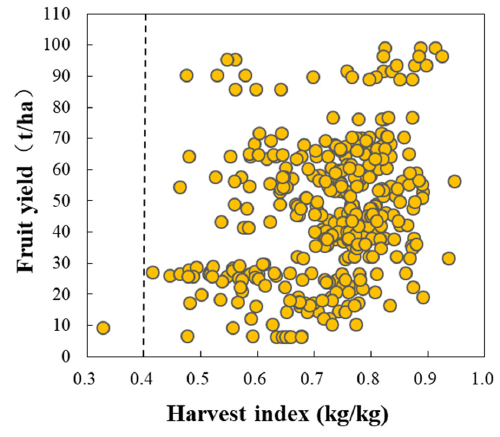
Figure 2. Distribution of fruit yield and harvest index (HI) of watermelon. The dotted line was used to exclude the value of HI < 0.4.